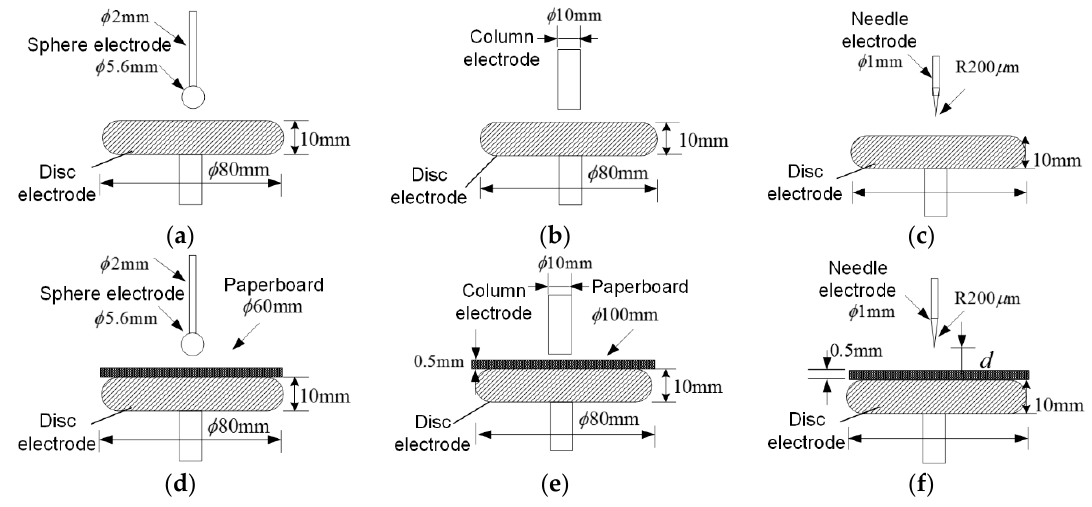
Figure 5. Sketch of breakdown models: ( a ) Sphere ‐ disc electrode; ( b ) Column ‐ disc electrode; ( c ) Needle ‐ disc electrode; ( d ) Sphere ‐ disc electrode (with paper); ( e ) Column ‐ disc electrode (with paper); and ( f ) Needle ‐ disc electrode (with paper).